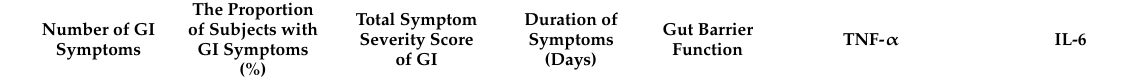
Table 3. Impact of probiotics on GI symptoms, inflammatory markers, and gut barrier function during training, competition, or single event and after the competition.